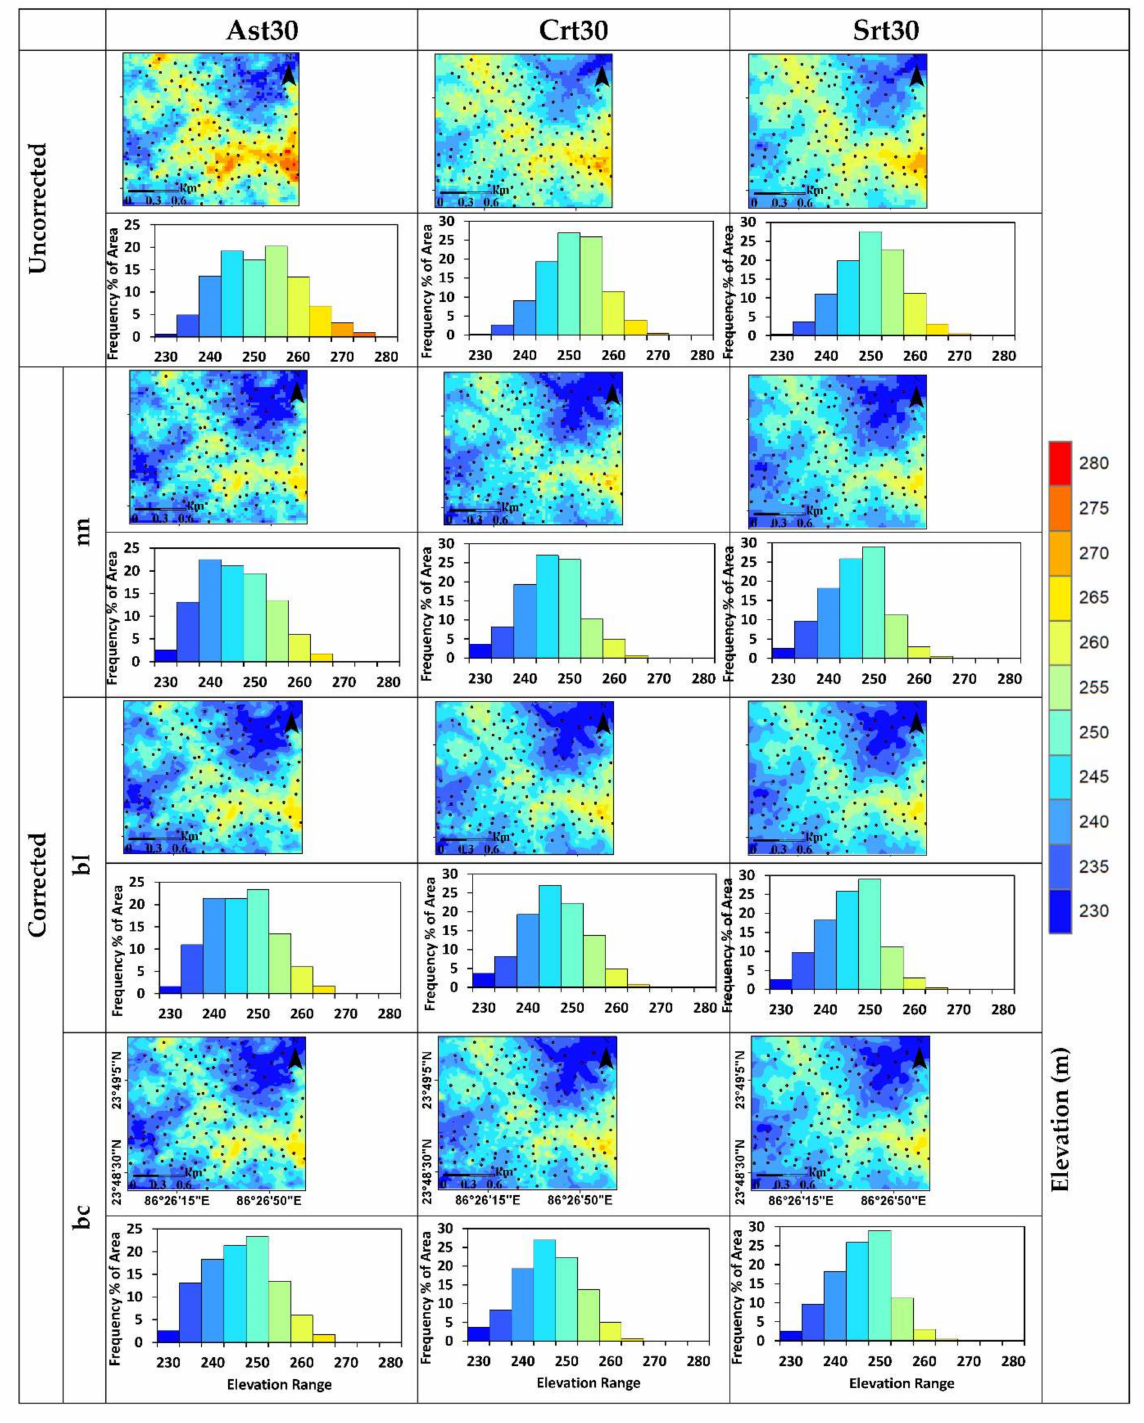
Figure 8. Spatial map depicting the elevation ranges and corresponding histogram (Frequency (% of area)) exhibiting the frequency distribution for uncorrected and corrected space-borne ele- vation datasets (Ast30 = ASTER GDEM V3, Crt30 = CartoDEM v3.R1, Srt30 = SRTM.v3) over the study region, IIT(ISM) campus and surrounding areas, Dhanbad. The nn, bl, and bc refer to the interpolation